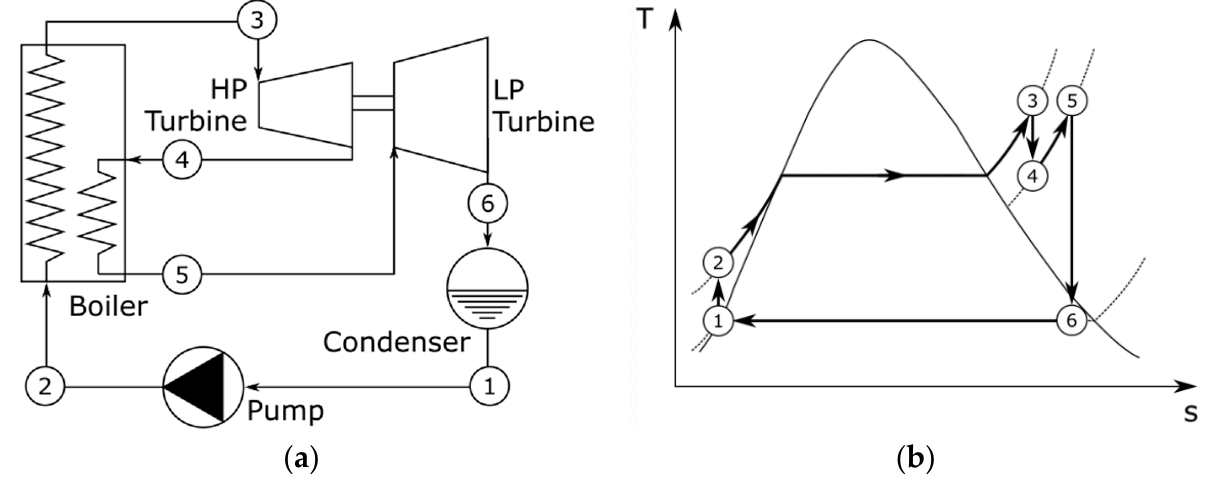
Figure 14. ( a ) Equipment and ( b ) T-s diagram of an ideal Rankine cycle with reheating.